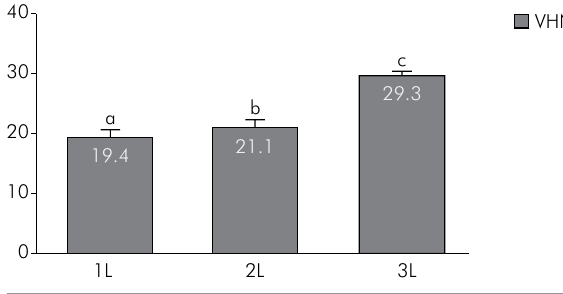
Figure 2. Vickers hardness number (VHN) of dual cure resin cement light cured through layered resin overlays. VHN of the three groups was statistically significant ( p < 0.05). 1L =